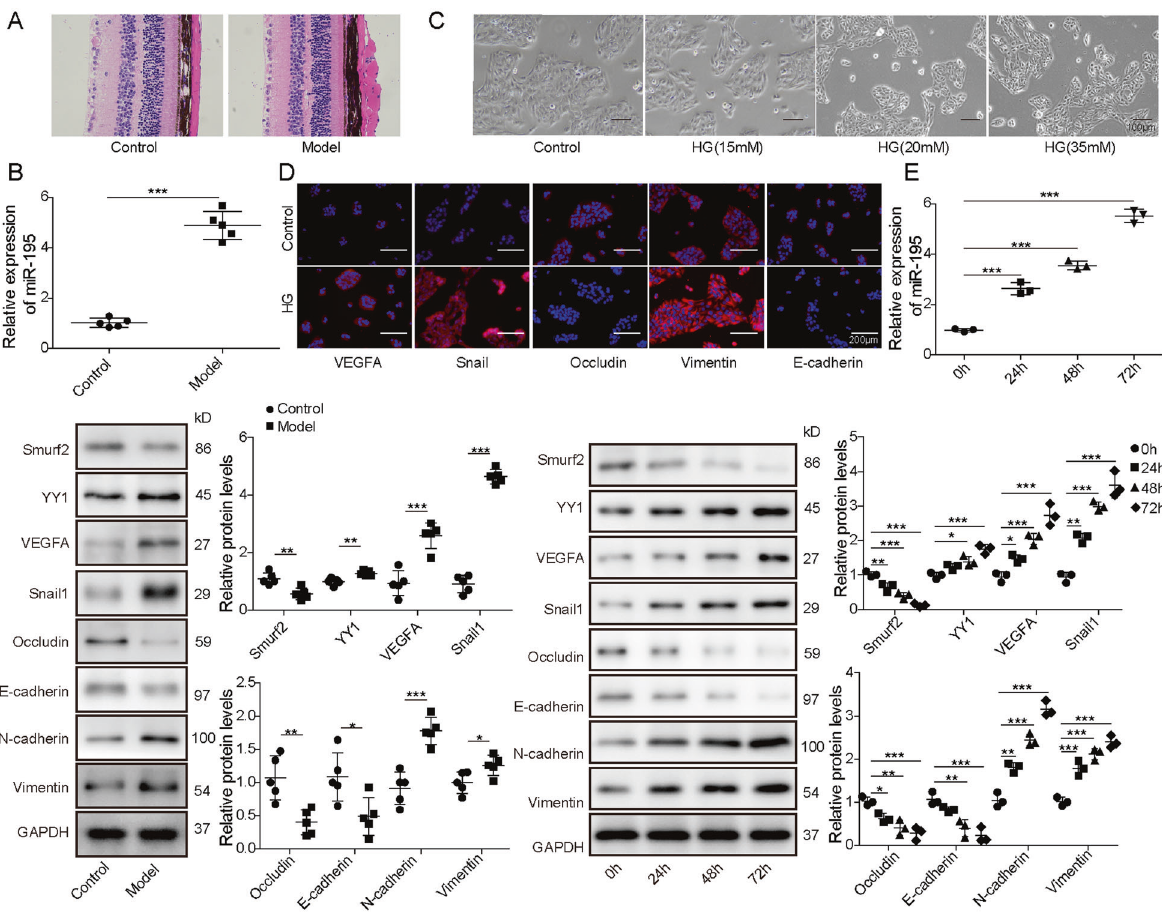
Fig. 1 The expression of miR-195, YY1, VEGFA, Snail1, and Smurf2 in STZ-induced diabetic mice and HG-stimulated ARPE-19 cells. A The pathology of retinas from control or model group was analyzed by HE staining. B MiR-195, Smurf2, YY1, VEGFA, Snail1, Occludin, E-cadherin, N-cadherin, and Vimentin levels were detected via qRT-PCR or western blotting in the retinas from control or model group. C Cell morphology was observed under microscope in ARPE-19 cells after stimulation of different doses of glucose. Magni fi cation: ×100. D VEGFA, Snail1, Occludin, E-cadherin, and Vimentin levels were examined by immuno fl uorescence in ARPE-19 cells in control or HG group. Magni fi cation: ×200. E MiR-195, Smurf2, YY1, VEGFA, Snail1, Occludin, E-cadherin, N-cadherin, and Vimentin levels were examined by qRT-PCR or western blotting in ARPE-19 cells after 0, 24, 48, and 72 h of HG exposure. For each analysis, three technical replicates were performed and three biological independently performed replicates are included, * p < 0.05, ** p < 0.01, *** p <